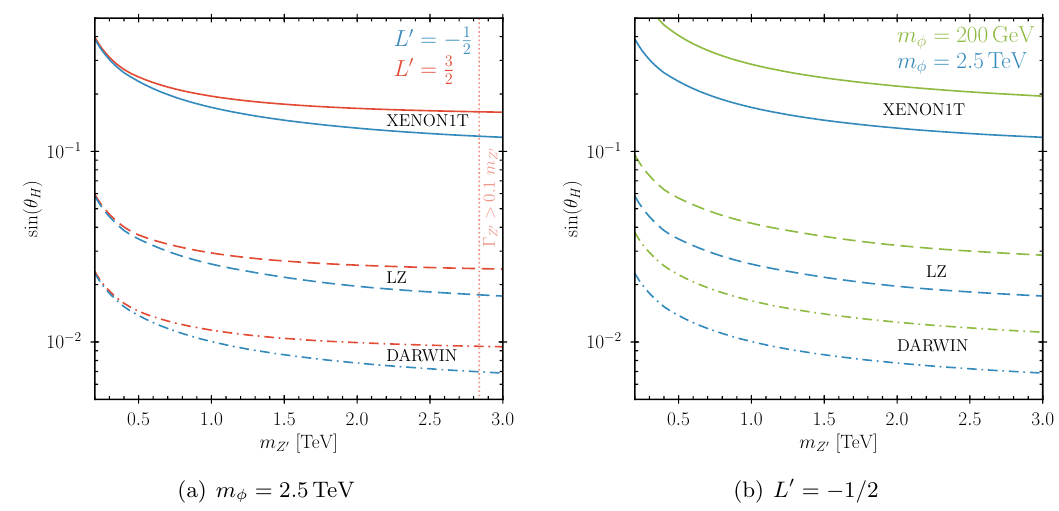
Figure 6 . Direct detection limits on the Higgs mixing angle (cid:18) H for lepton number charges (left plot, m (cid:30) = 2 : 5 TeV) of L 0 = 1 = 2 (blue) and L 0 = 3 = 2 (red), and scalar masses (right plot, (cid:0) L 0 = 1 = 2) of m (cid:30) = 200 GeV (green) and m (cid:30) = 2 : 5 TeV (blue). The current constraints from (cid:0) the XENON1T experiment [44] are shown as solid lines, the long-dashed and dash-dotted lines indicate the projected sensitivities of LZ [45] and DARWIN [46], respectively. As before, the DM mass is set to the value reproducing the measured relic